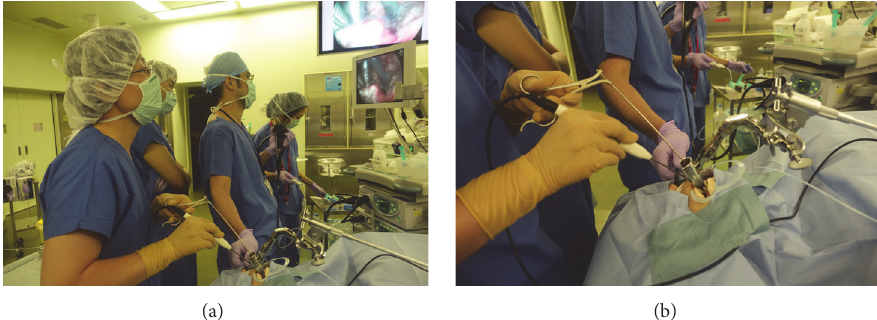
Figure 3: (a) ELPS is a video-assisted surgery performed by two physicians: a head and neck surgeon acting as the operator and an endoscopic specialist acting as the endoscopist. They observe the same TV monitor in the operation room. (b) The operator uses the curved forceps and the electric needle knife, while the endoscopist inserts the transnasal endoscope through the